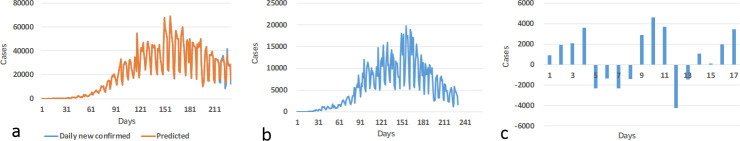
Brazil infected cases.a) Infection of predicted and confirmed per days, b) Infection prediction with best government performance, c) Infection prediction error.